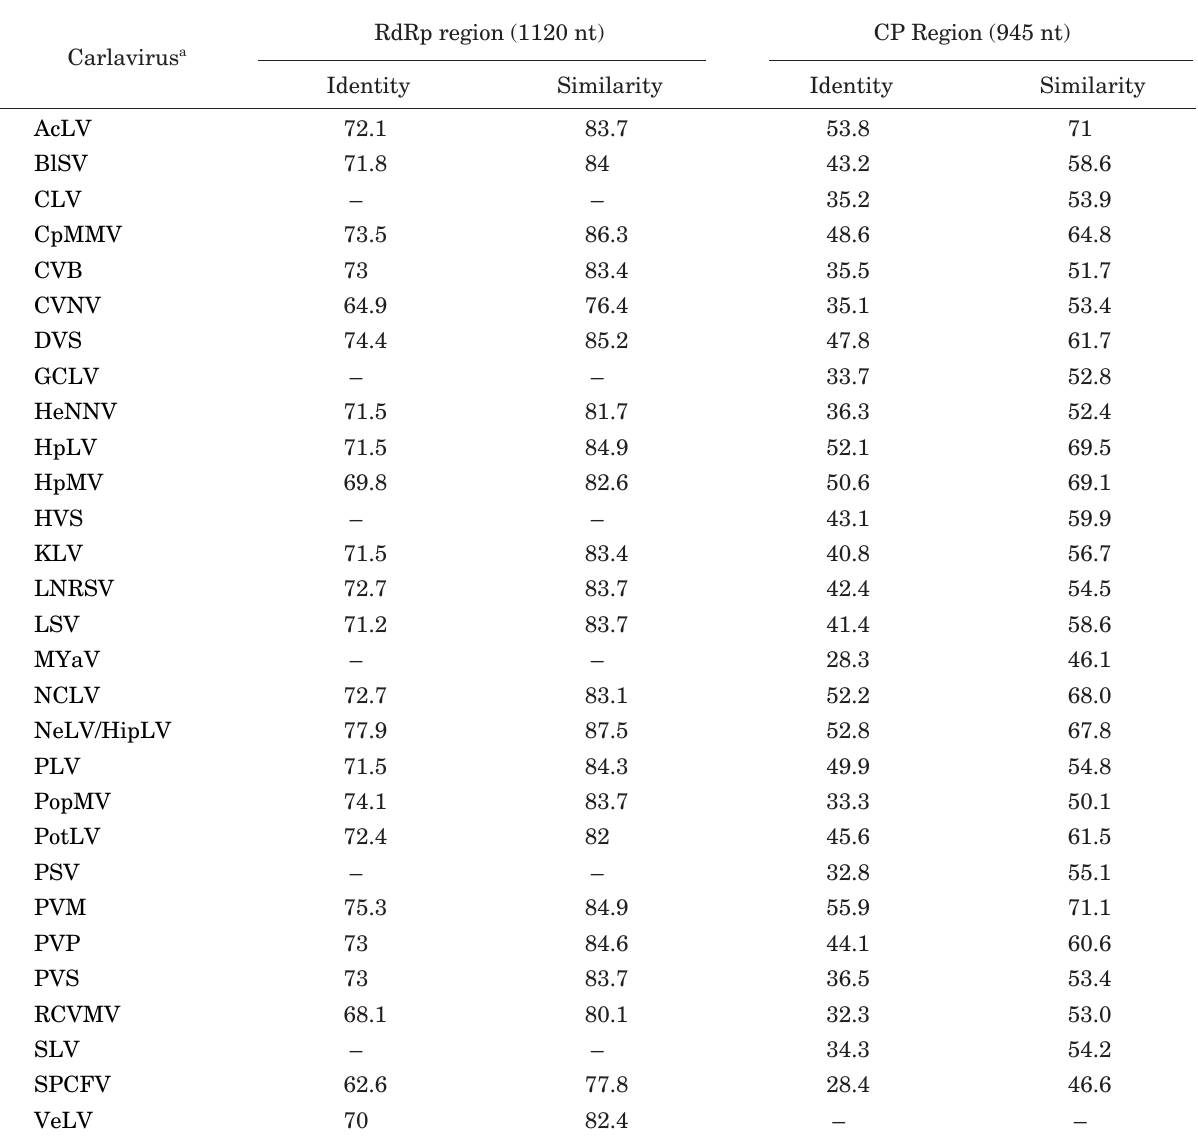
Table 2. Percentage identities and similarities (refers to amino acid residues of the same group) of the RdRp and CP amino acids sequences between CapLV-L7 and other members of the genus Carlavirus .